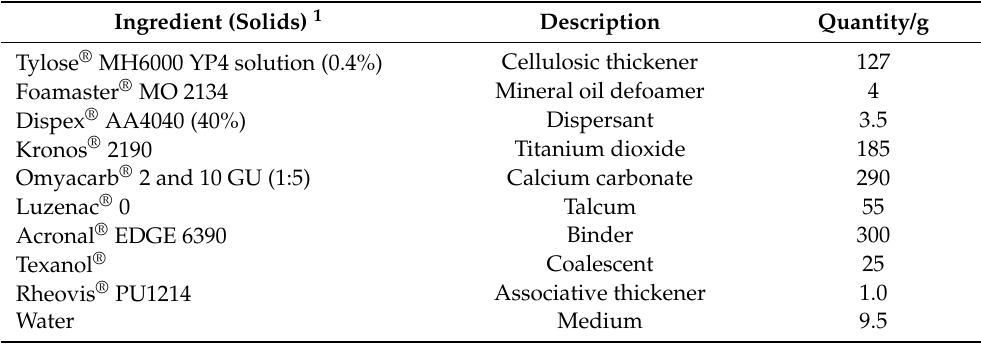
Table A1. Façade paint formulation for binders A to D. The solids content was 68%; the PVC was 55%; the pH was adjusted to 8.2–8.5 using ammonia (and to pH 10 in the case of D2). All brand names are each respective trademarks of the following companies: Shin-Etsu Chemical Co., Inc. (Tylose ® ) (Tokyo, Japan), Kronos International Inc. (Kronos ® ) (Dallas, TX, USA), Omya AG (Omyacarb ® ) (Auftlingen, Switzerland), Imerys S.A. (Paris, France) (Luzenac ® ), Eastman Chemical Inc. (Texanol ® ) (Kingsport, TN, USA) and BASF SE (Acronal ® , Dispex ® , Foamaster ® , Rheovis ® ) (Ludwigshafen, Germany). Distilled water was used (BASF SE, Ludwigshafen, Germany).